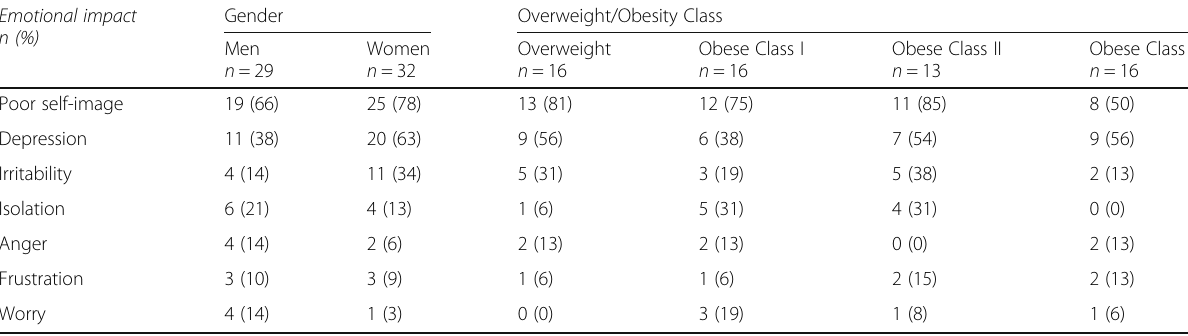
Table 3 Weight-related emotional symptoms by gender and weight class Emotional impact n